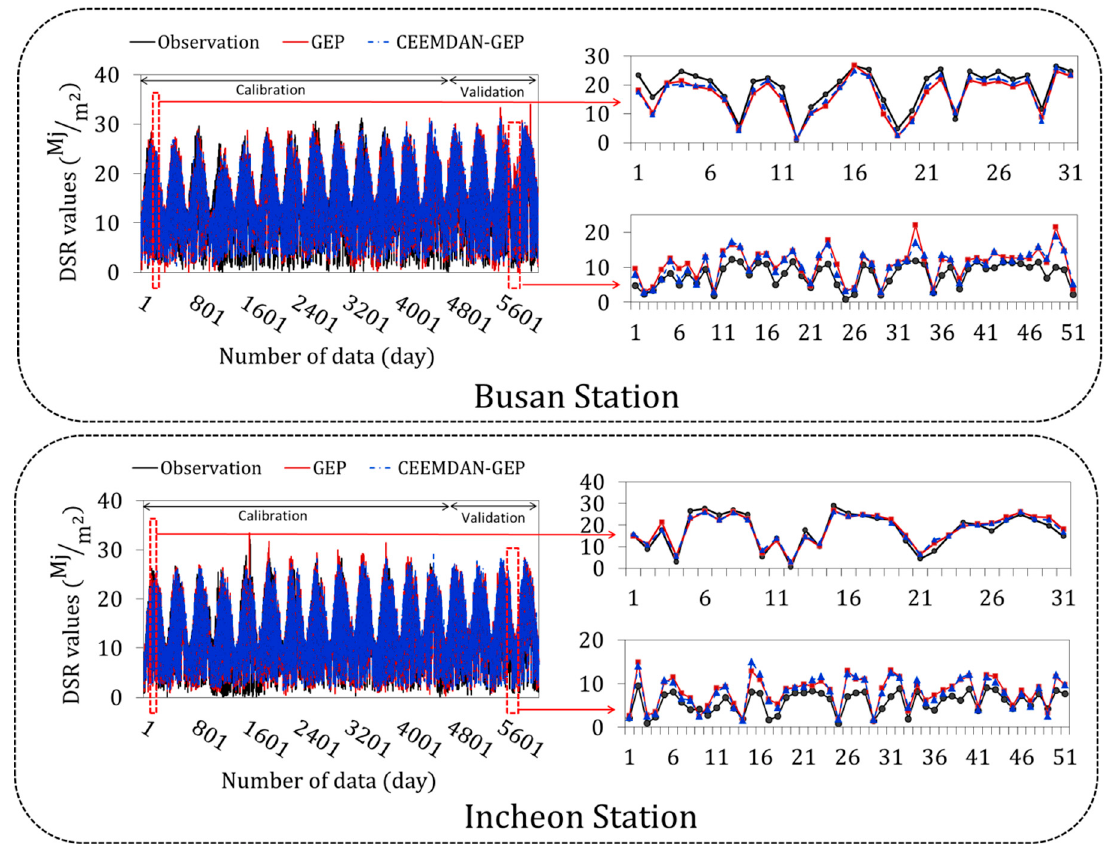
Figure 5. Time-series plots between observed and forecasted DSR for GEP and CEEMDAN-GEP models for calibration and validation phases at Busan and Incheon stations.